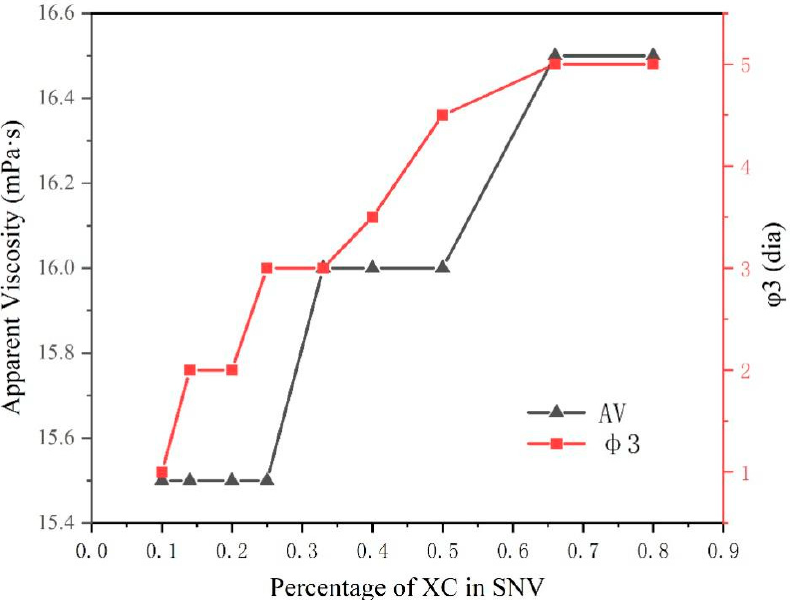
Figure 5. Apparent viscosity and Φ 3 values of SNV bentonite slurries with different ratios of the two slurry components.